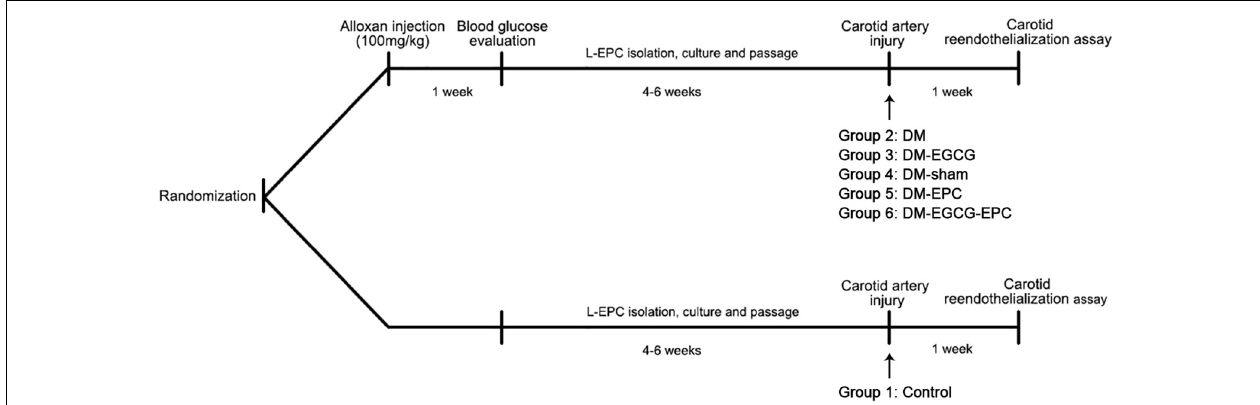
FIGURE 1 | Timeline of in vivo experiments. Rabbits were randomized into six groups. Group 1 (Control): control rabbits given saline intragastrically after injured carotid artery operation. Group 2 (DM): diabetic rabbits given saline intragastrically after injured carotid artery operation. Group 3 (DM-EGCG): diabetic rabbits given EGCG 50 mg/kg/day intragastrically for 7 days after injured carotid artery operation. Group 4 (DM-sham): injured carotid artery of diabetic rabbits washed and then incubated 10 min by saline after injured operation. Group5 (DM-EPC): autologous L-EPCs transplanted into the area of injured carotid artery of diabetic rabbits after injured carotid artery operation. Group 6 (DM-EGCG-EPC): EGCG pre-treated autologous L-EPCs transplanted into the area of injured carotid artery of diabetic rabbits after injured carotid artery